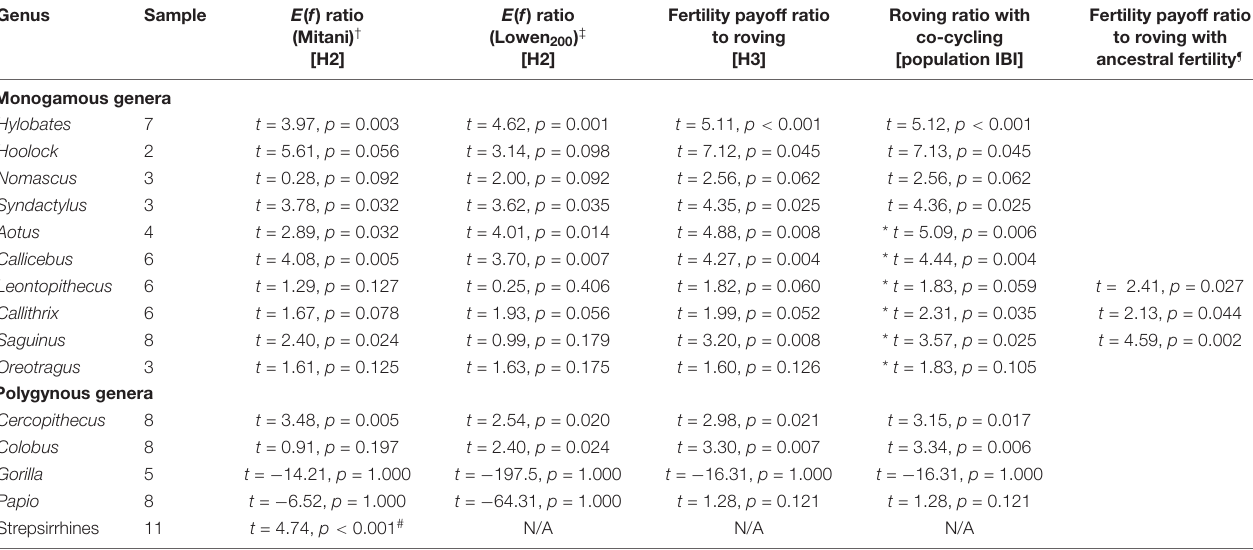
Figure 5A plots the payoff ratio to a roving male, E ( p )/ F adj , in terms of the expected number of sirings he would gain relative to that obtained by a social male for each sampled population (adjusted, as in Figure 2 , for the higher reproductive rates